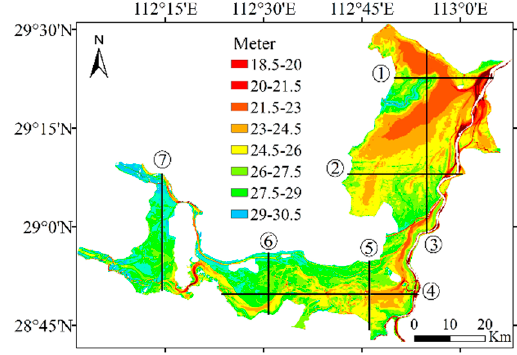
Figure 15. Text areas and check cross section.